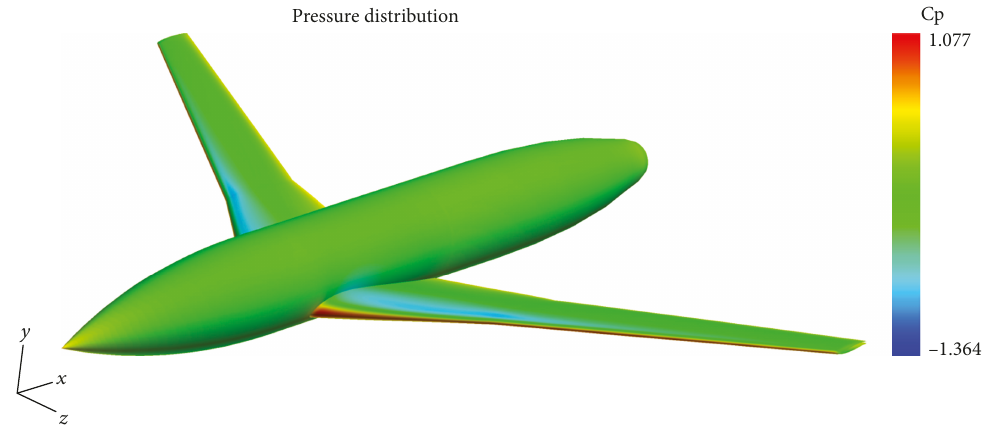
Figure 25: Cp distribution on ARA M100 wing-fuselage con fi guration. M = 0 6 , α = 1 733 ° , and Re/m = 13 × 10 6 . Table 5: Lift and drag coe ffi cients on ARA M100, with and without side shear wind.